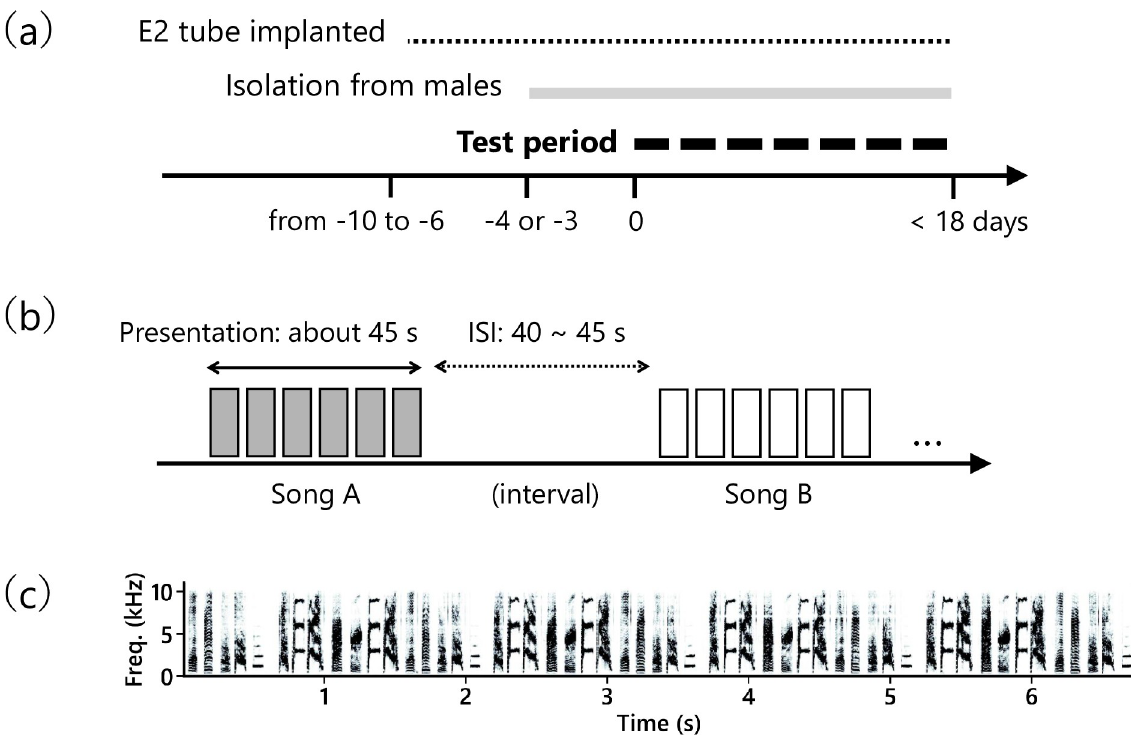
Fig 1. Experimental schedule and stimuli. (a) Overall schedule of the experiment. Each line above the horizontal axis indicates the period in which birds were under that manipulation. The start of the song playback test was set as day zero. (b) A schematic diagram of the stimulus presentation schedule in a single test. Five songs, each composed of 6 renditions (6 rectangles in the figure) were played. (c) A spectrogram of one rendition of the song stimulus is shown as an example.